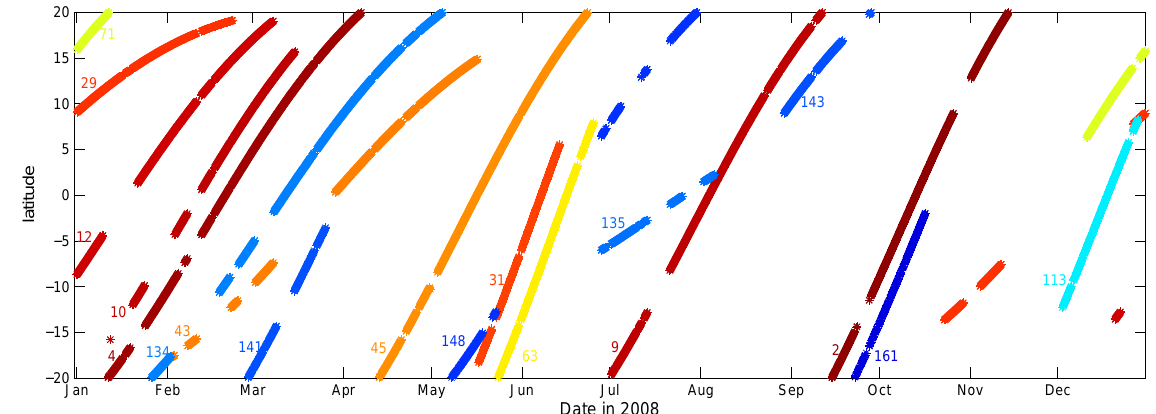
Figure 2. Locations of occultations selected for the analysis. Each color corresponds to a particular star, whose number in the GOMOS catalogue is written near the corresponding line.